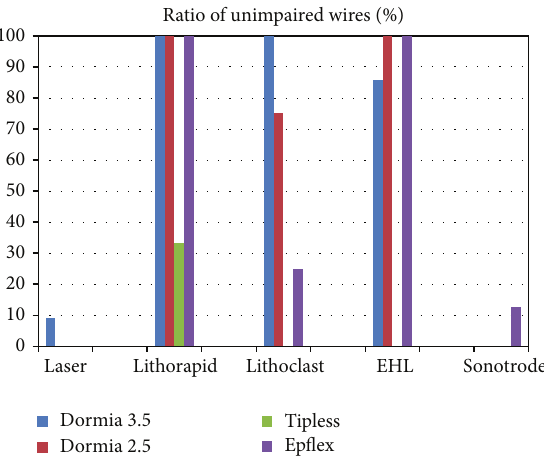
Figure 10: Over all the lithotripters, the laser and the ultrasonic device have the lowest ratio of unimpaired